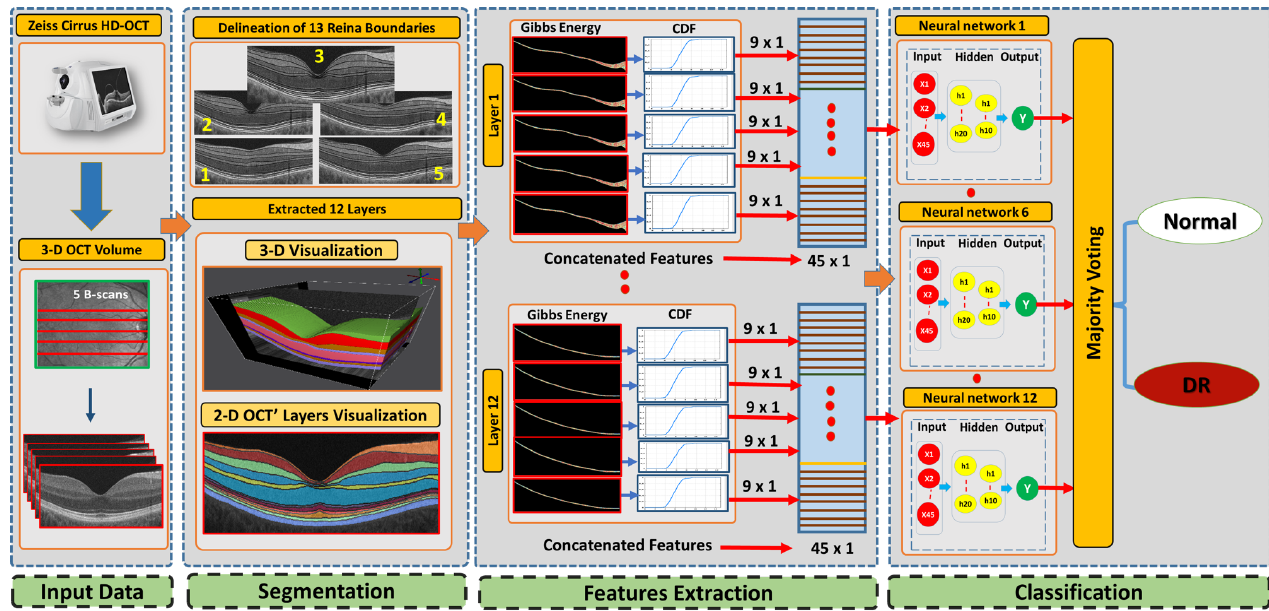
Figure 1. The framework of the proposed CAD system for DR diagnosis using 3-D OCT